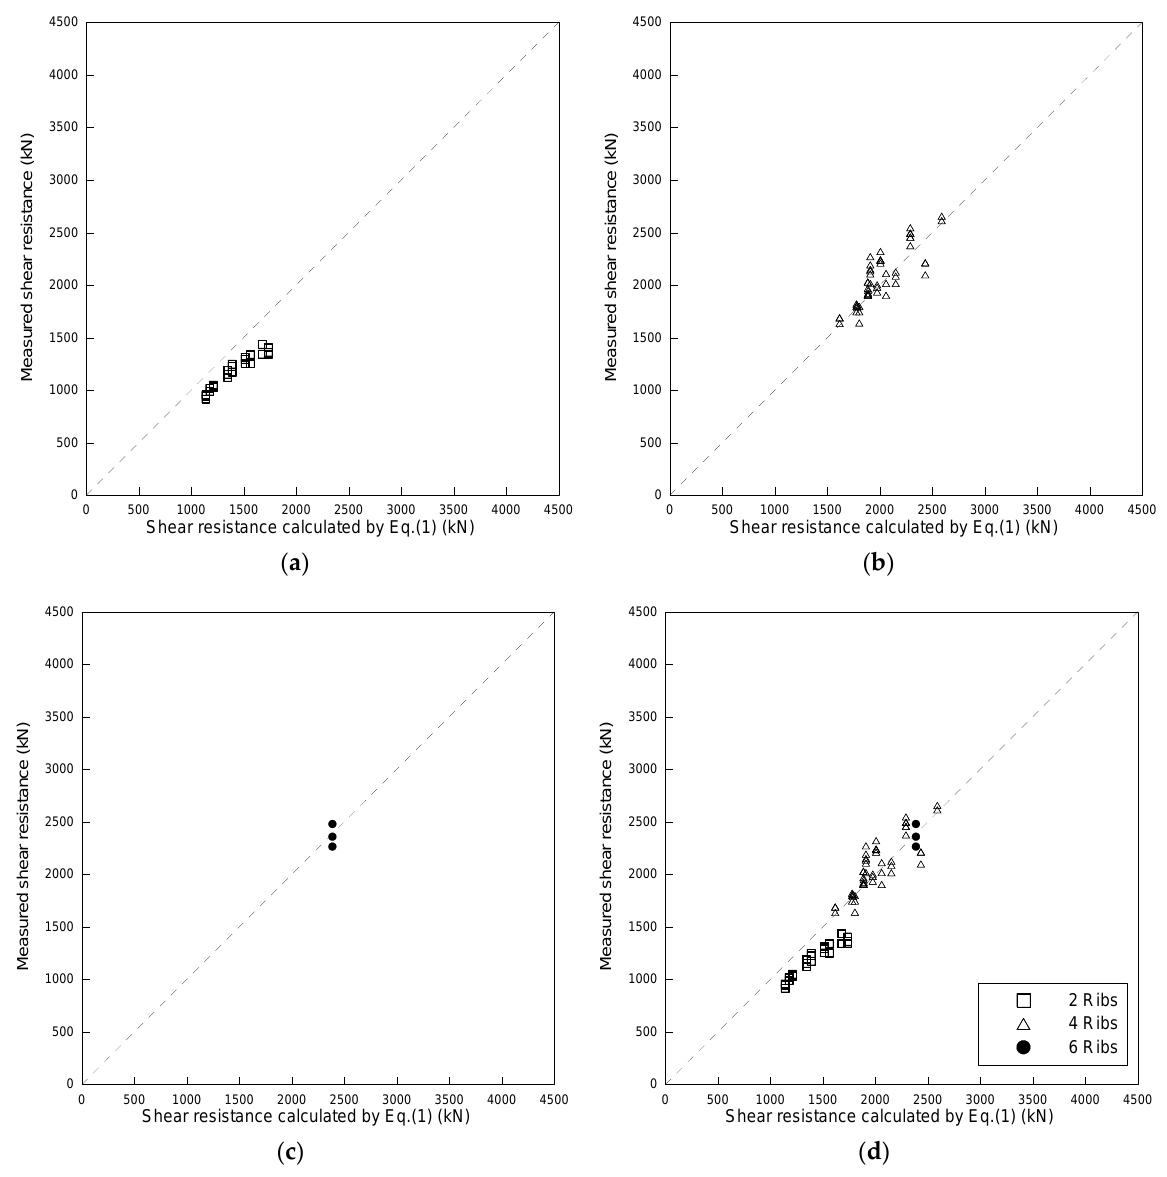
Figure 4. Comparison of experimental and calculated data (Equation (1)): ( a ) 2 ribs, ( b ) 4 ribs, ( c ) 6 ribs. ( d ) Total data. Table 6. Statistical characteristics of estimations by Equation (1).